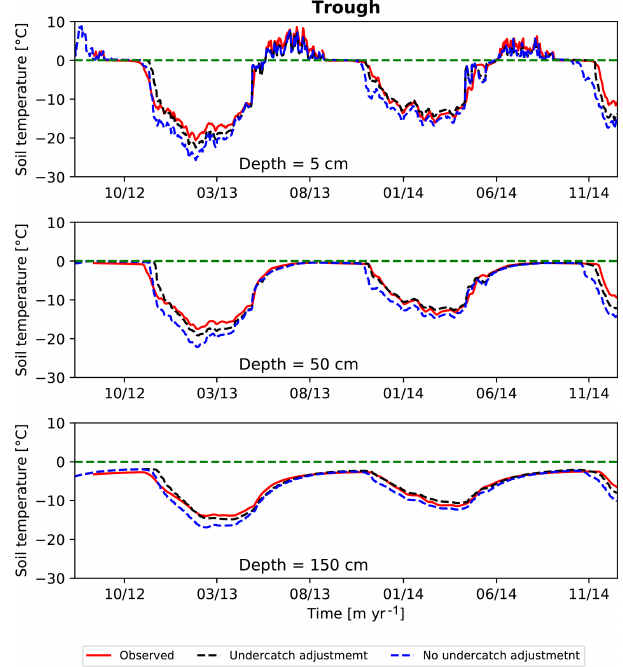
Figure 7. Sensitivity of the simulated soil temperatures to the snow precipitation undercatch adjustment. Smaller snowpack enhances heat escape from the soil due to the reduced insulating effect of the